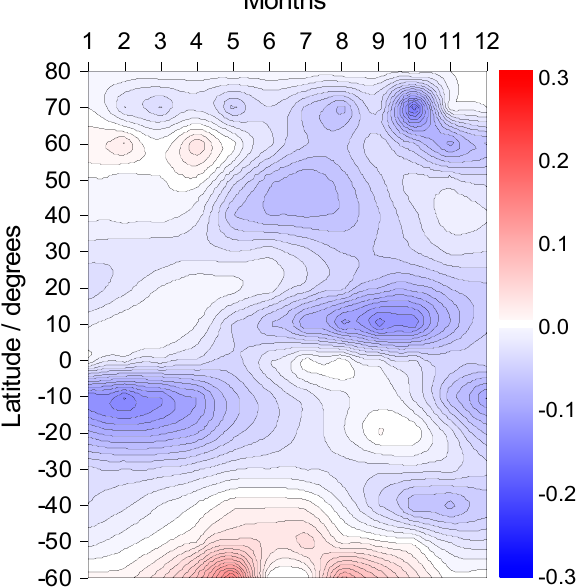
Figure 4. Hovmoller diagram of mean values of the FCover differences between TRAGL and GEOV1 FCover products for different 10°-latitude bands in each month for 2001–2005.